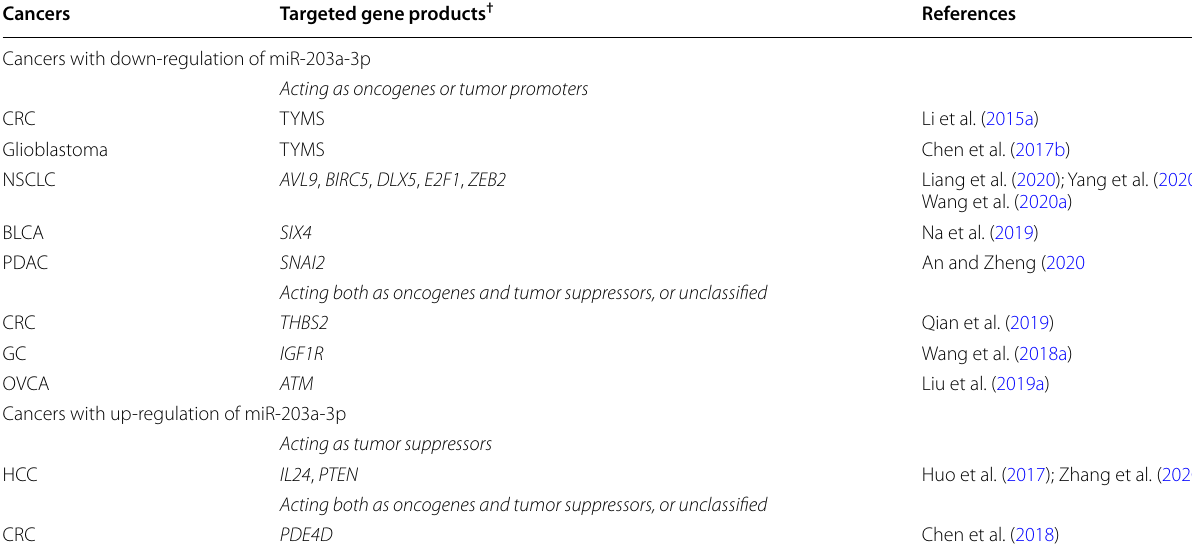
† mRNAs encoding the following proteins: ATM codes for ATM Serine/Threonine Kinase (Ataxia Telangiectasia Mutated), although it is considered as a tumor suppressor, ATM signaling can be involved in chemoresistance of cancer cells (Cremona and Behrens 2014) as well as promote the EMT process (Liu et al. 2019a); AVL9 codes for cell migration associated protein and is an oncogene in NSCLC; BIRC5 can be regarded as an oncogene that codes for apoptosis inhibitor Survivin; DLX5 codes for transcriptional activator and acts as oncogene (Tan and Testa 2021); E2F1 encodes E2F Transcription Factor 1; IGF1R encodes the Insulin-like Growth Factor 1 Receptor (Werner et al. 2016); IL24 codes for interleukin 24, which can induce apoptosis in a variety of cancer cells, thereby acting as a tumor suppressor; PDE4D encodes cAMP-specific Phosphodiesterase 4D; PTEN is a tumor suppressor gene encoding Phosphatase and Tensin Homolog; SIX4 codes for transcriptional regulator and acts as oncogene; THBS2 codes for Thrombospondin 2; SNAI2 codes for SLUG which represses the gene encoding E-cadherin and thus promotes the EMT process of cancer